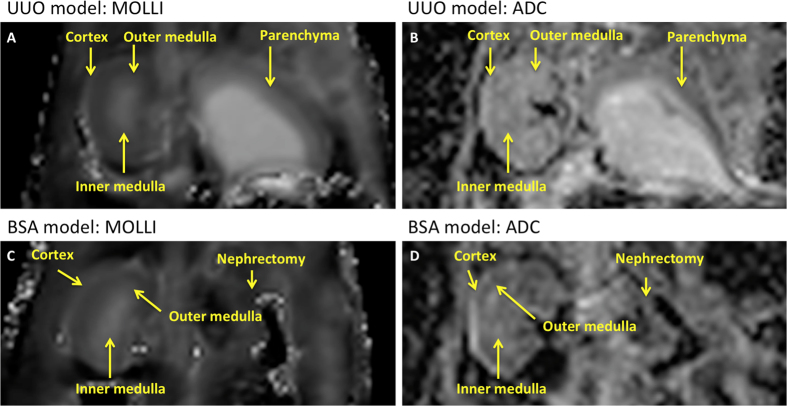
Representative T1 maps and ADC maps of the unilateral ureteral obstruction
(UUO) model (A,B) and bovine serum albumin (BSA) nephritis model
(C,D). First column, coronal MOLLI T1 maps in the UUO model
(A) and in the BSA example (C) followed by coronal ADC map
obtained with RESOLVE sequence (B,D). The renal cortex, and
the outer and inner medulla were identified on the BSA model and sham, as
well as the contralateral unobstructed kidney of the UUO rats. Layers were
not distinguished on the left obstructed UUO kidney due to renal parenchyma
atrophy.